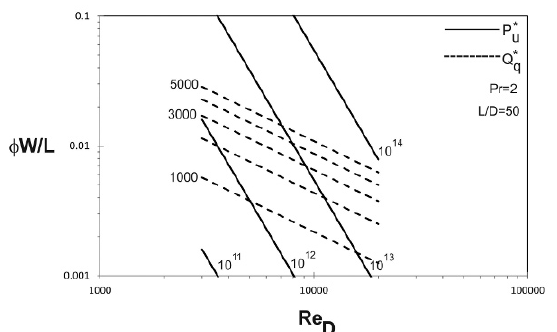
Figure 12. Φ W/L group versus the Reynolds number for differ- ent dimensionless heat transfer conductance and fluid pumping power (turbulent regime and constant heat-flux boundary)